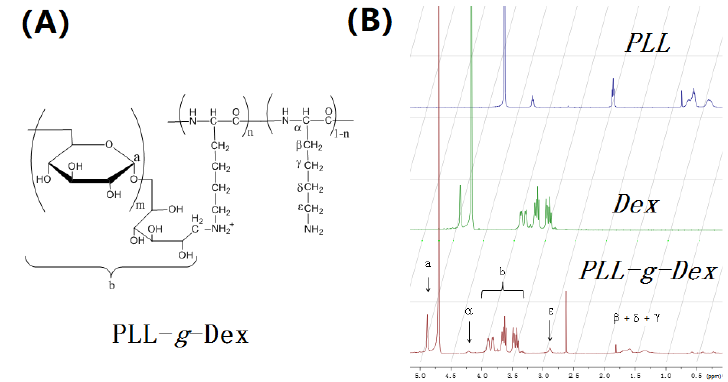
Figure 1. ( A ) Structural formula of poly( L -lysine)(PLL)- g -Dex. ( B ) 1 H-NMR spectra of PLL, Dex and PLL- g -Dex in D 2 O. The dextran content of the copolymer was calculated from 1 H-NMR signals assigned to PLL ( ε -CH 2 ) and dextran (C 1 -H,